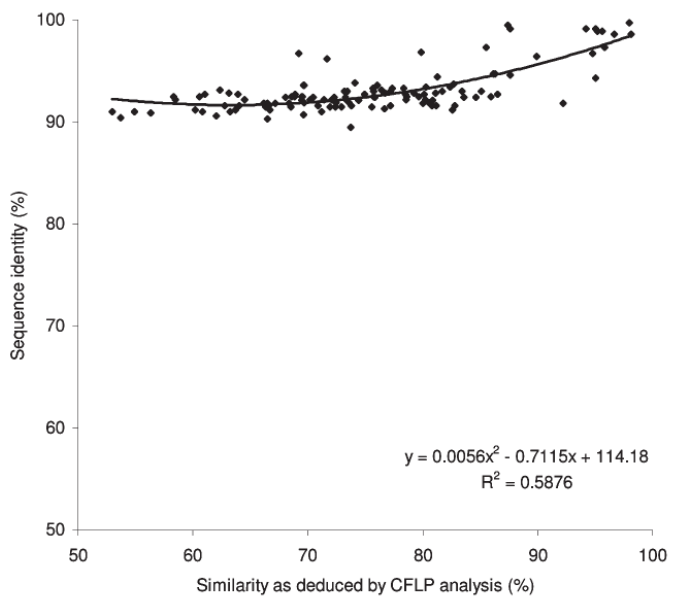
Fig. 2. Comparison of sequence identity and similarity between patterns generated by CFLP